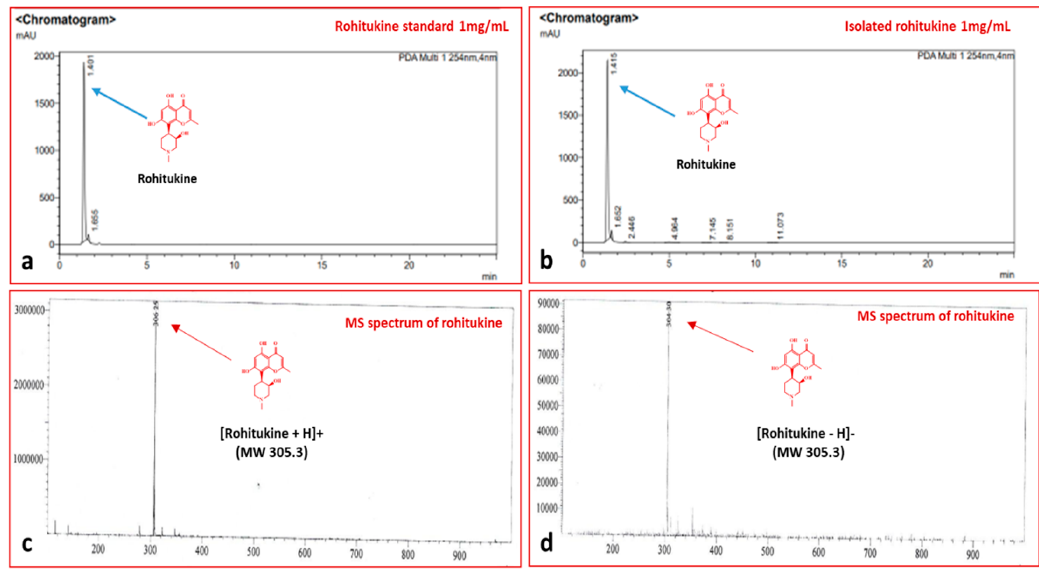
Figure 1. HPLC and MS chromatograms showing the purity of rohitukine isolated from leaves of D. gotadhora. ( a ) Chromatogram of standard rohitukine, 1 mg/mL. ( b ) Peak of rohitukine isolated from D. gotadhora . ( c , d ) Mass spectra showing the presence of a single peak of rohitukine (MW 305.3).